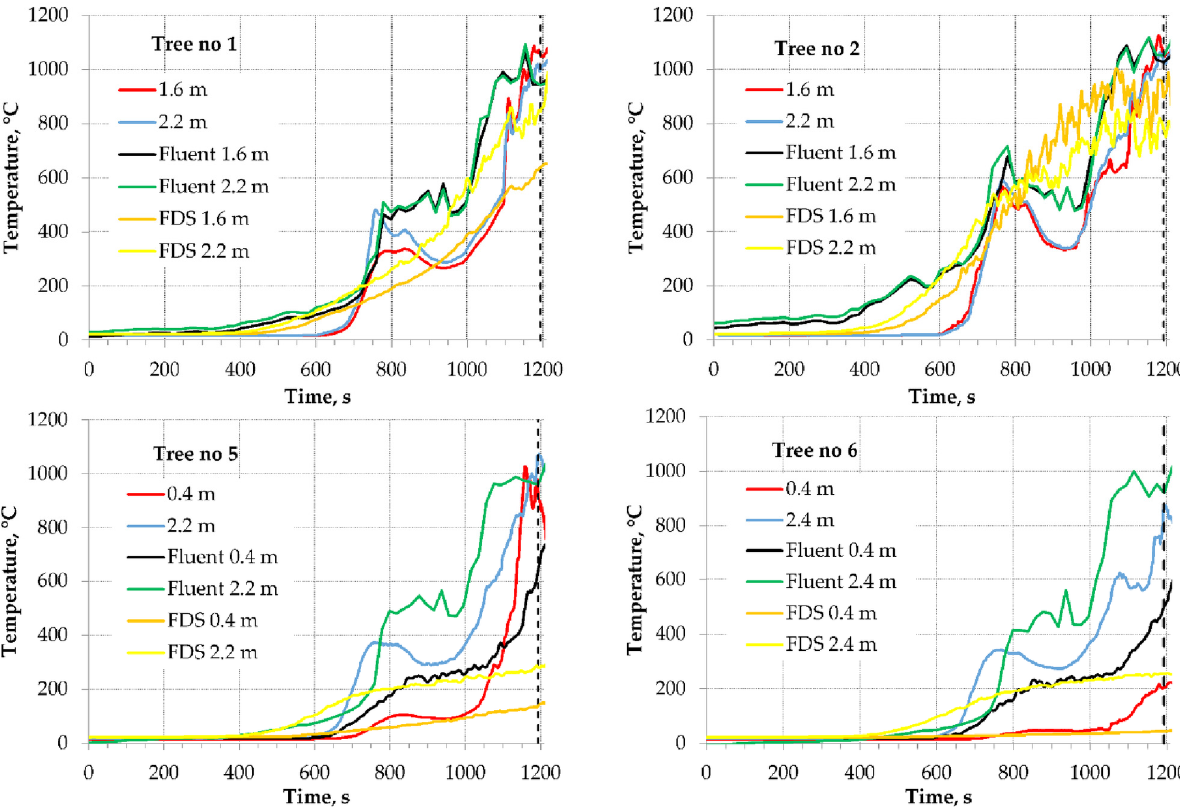
Figure 11. Comparison of the selected temperature distributions for real and modeled (Fluent and FDS—ITP approach) fire.